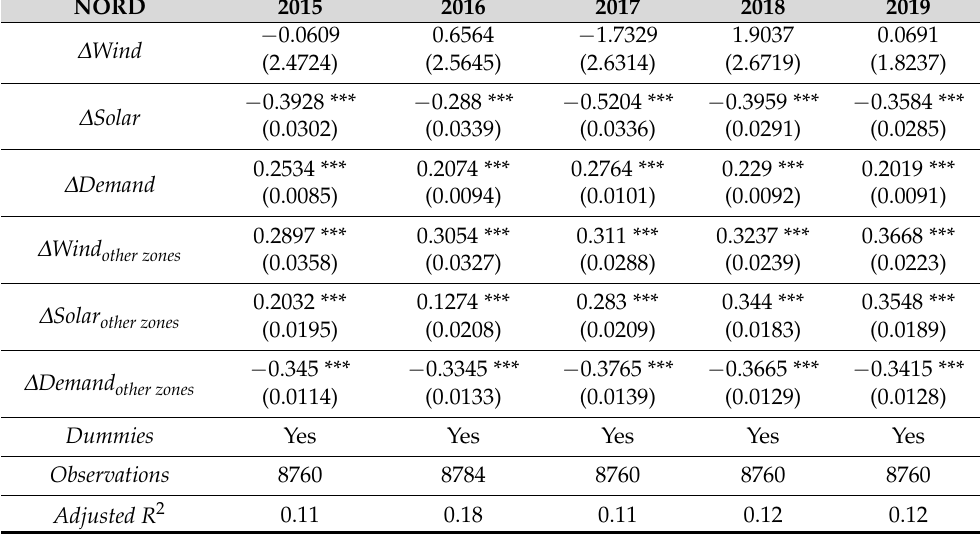
Table A9. OLS estimation of hourly changes in net input flow of NORD; results of Equation (1). NORD